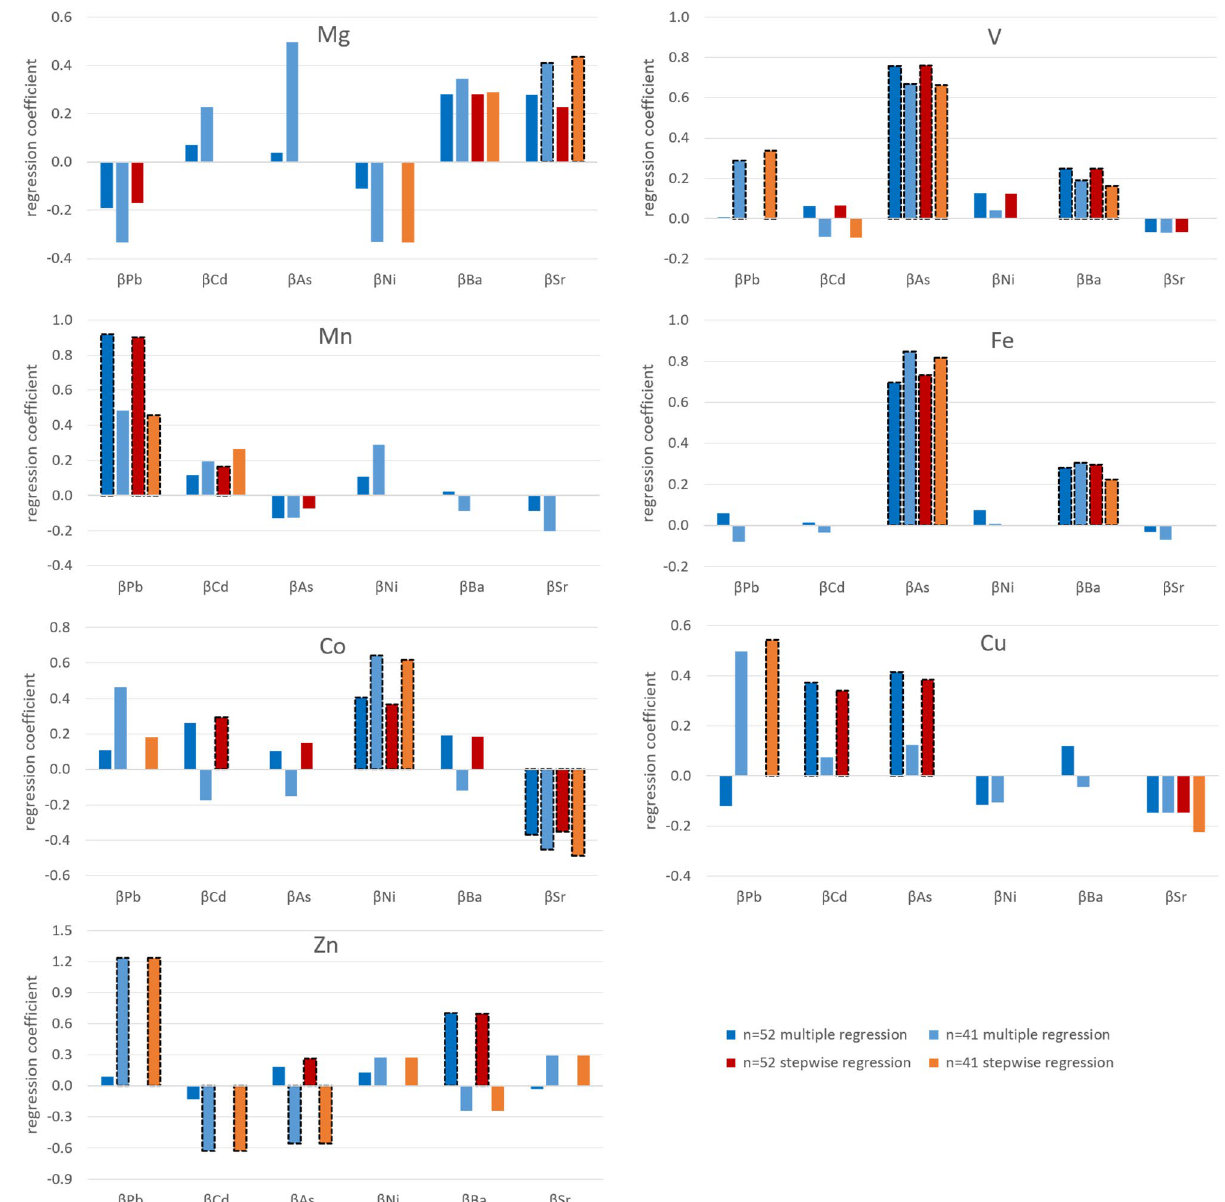
Figure 3. Comparison of regression coefficient β of four models of regression analysis: multiple regression ( n = 52 and n = 41 ) and stepwise regression ( n = 52 and n = 41 ) between physiological elements and elements causing toxic effects. The column with dashed outline represents the significant